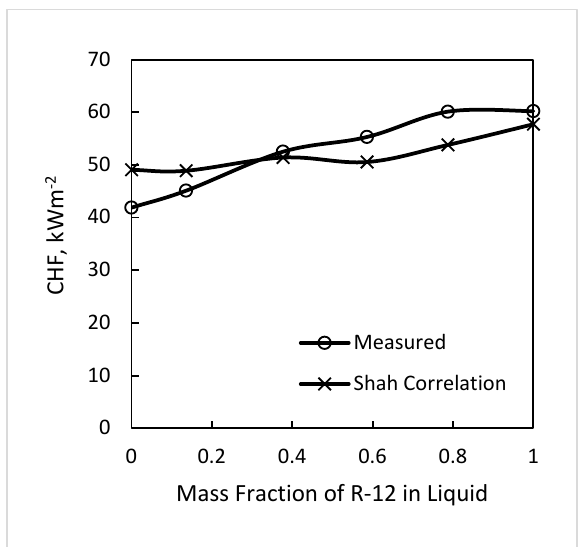
Figure 5. Effect of the component mass fraction on CHF. R-12/R-114 is in a vertical tube. Pressure is 1.2 MPa, subcooling is 23 K, and mass flux is 559-612 kgm − 2 s − 1 . Data of Celata et al. (1994b) [15] compared with the Shah (1987) [23] correlation.